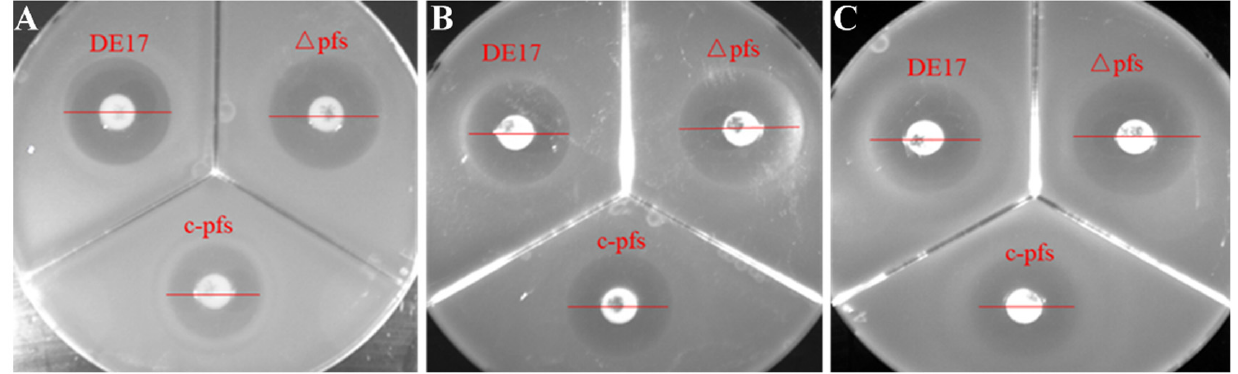
Figure 1. The size of the inhibition zones of different antibiotics against APEC strains. ( A ) Ampicillin, ( B ) amoxicillin, and ( C ) ceftazidime. After pfs gene deletion, the inhibition zone of the deletion strain DE17 ∆ pfs was larger than that of wild-type strain DE17 and complement strain c-pfs. Table 2. The MIC values of antibiotics against APEC tested with micro-dilution assay. Antimicrobial MIC Antibiotic